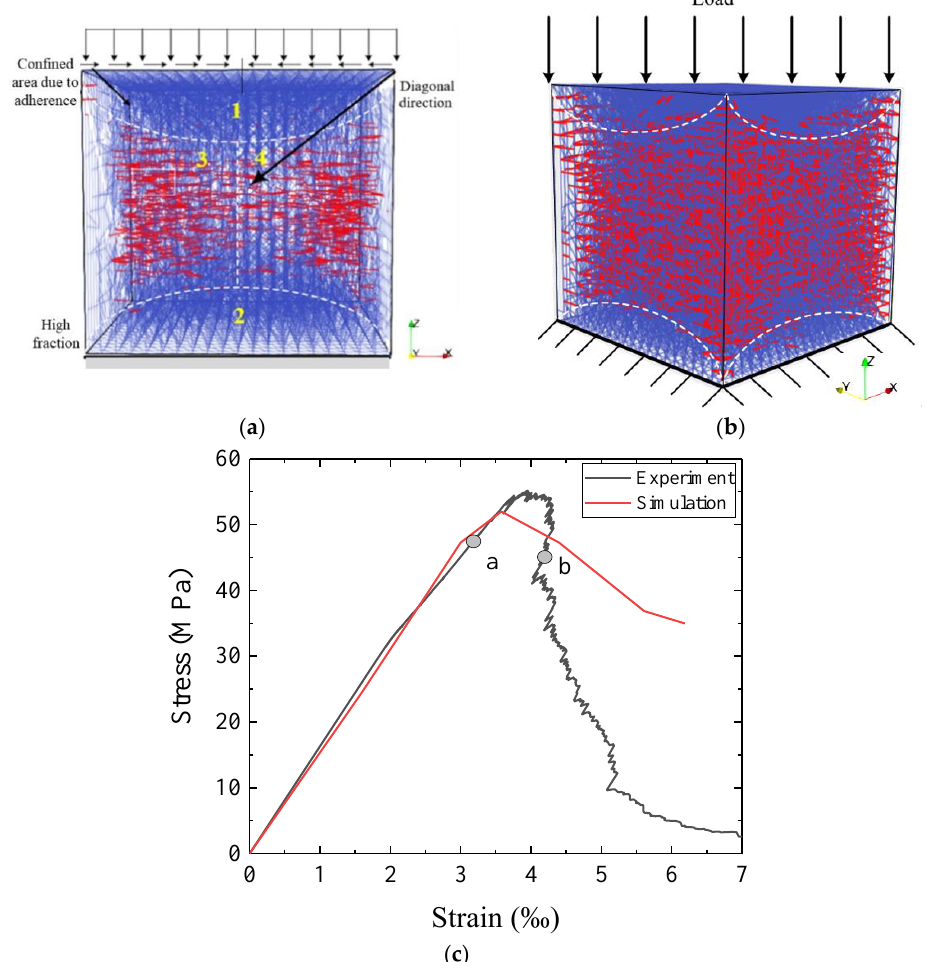
Figure 4. Uniaxial compressive test ( a ) crack pattern at a point, ( b ) crack pattern at b point (red-cracked element), ( c ) stress-strain response.